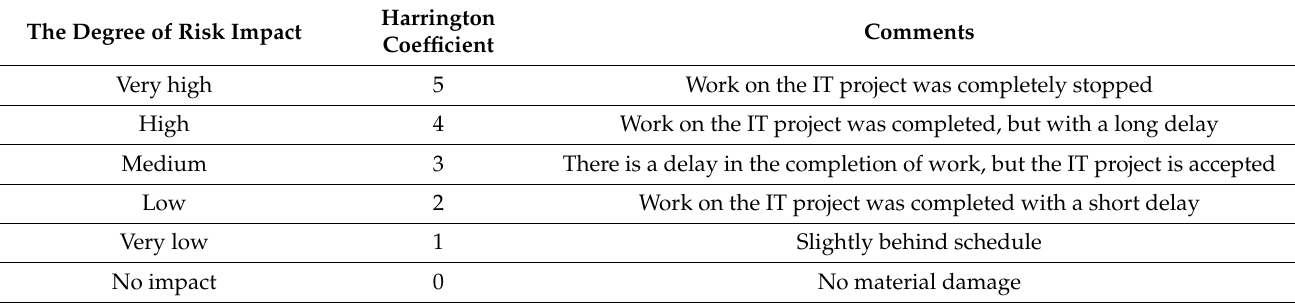
Table 1. Harrington coefficients for assessing the possible impact of risk in the event of its materialization.